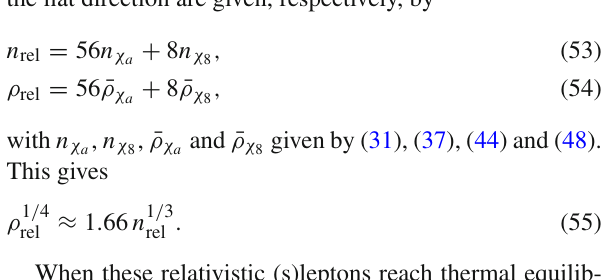
the flat direction are given, respectively,